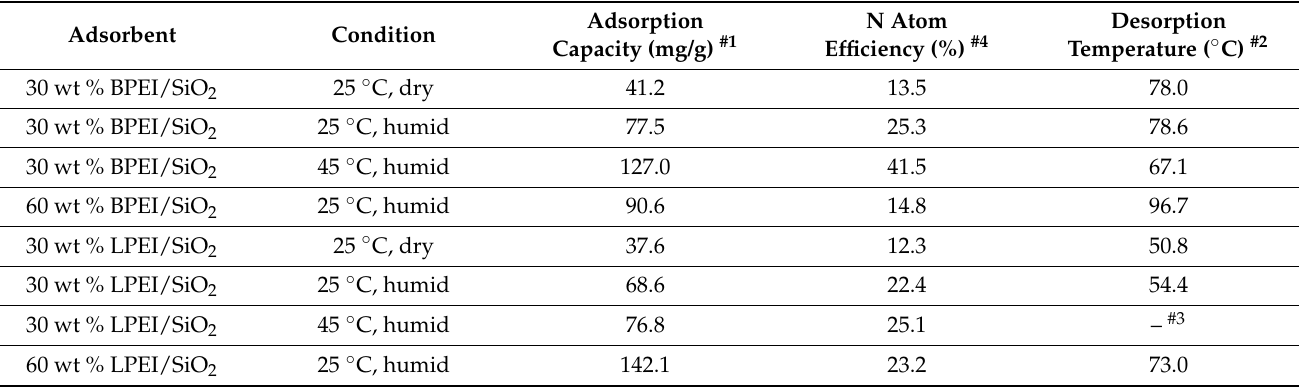
Figure 1. ( a ) BPEI and LPEI molecular structures; ( b ) CO 2 capture (5000 ppm CO 2 in He balance with/without H 2 O vapor, 200 mL/min) at 25 ◦ C; ( c ) TPD profile (5 ◦ C/min, 200 mL/min of pure He). Table 1. Adsorption and desorption performance of BPEI and LPEI supported on SiO 2 under different conditions. Note: 5000 ppm of CO 2 in He balance for adsorption and pure He for desorption. RH = 73.9% (dew point: 20 ◦